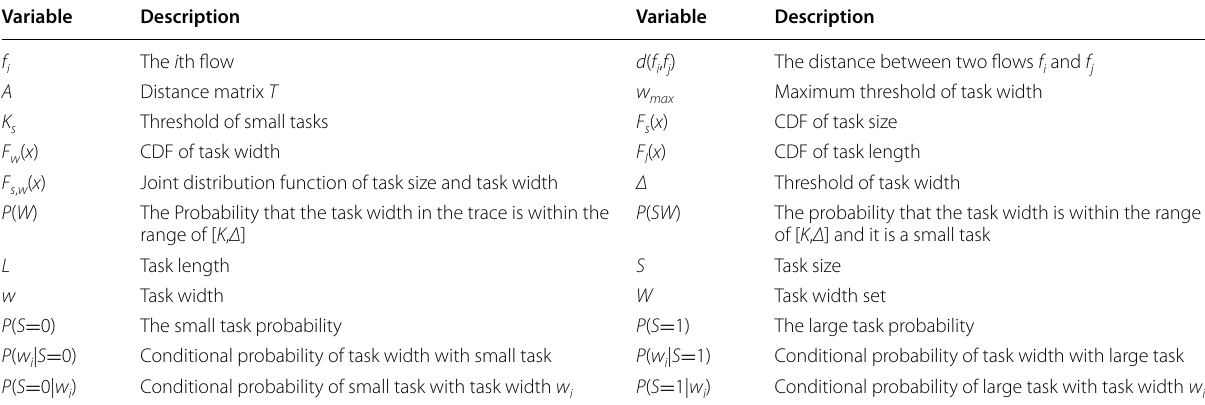
Table 1 Variables in BTP Variable Description